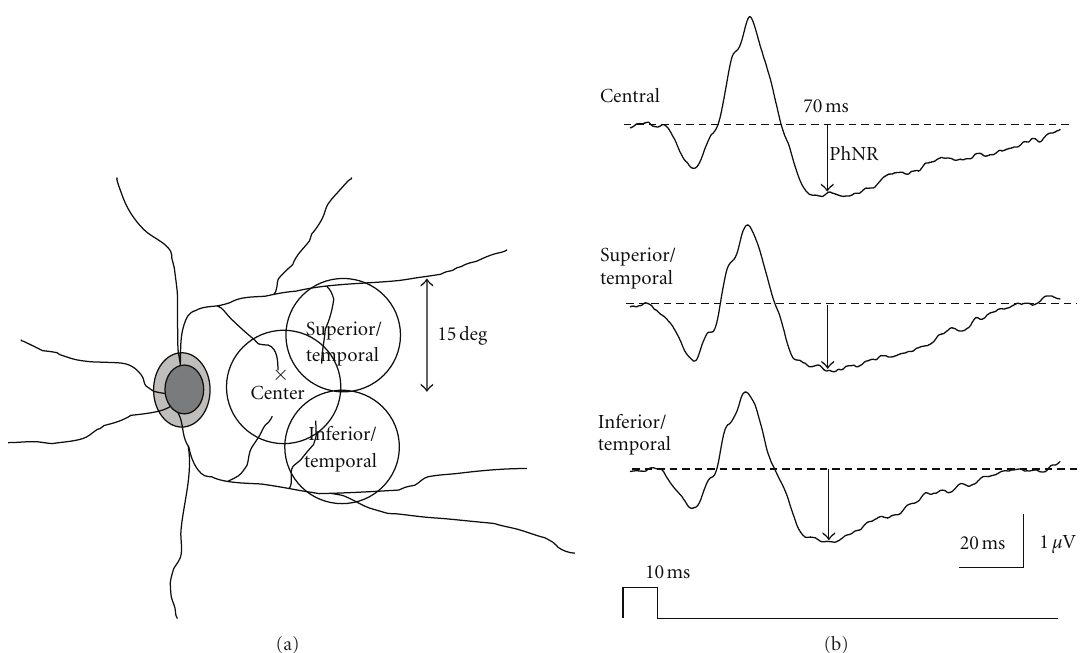
Figure 7: (a) Recording sites of focal electroretinograms. (b) Representative waveforms of the focal electroretinogram recorded from a normal subject. PhNR: photopic negative